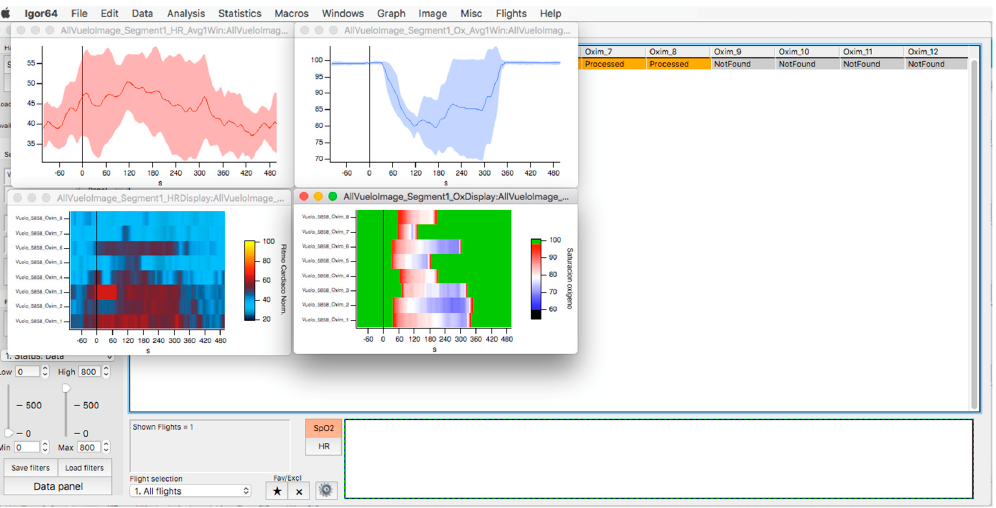
Figure 10. Oxygen saturation (light blue) and heart rate (red) curves are represented as the average and standard deviation of the total number of members of the selected flight (upper graphs). The respective heat maps are shown at the bottom. respective heat maps are shown at the